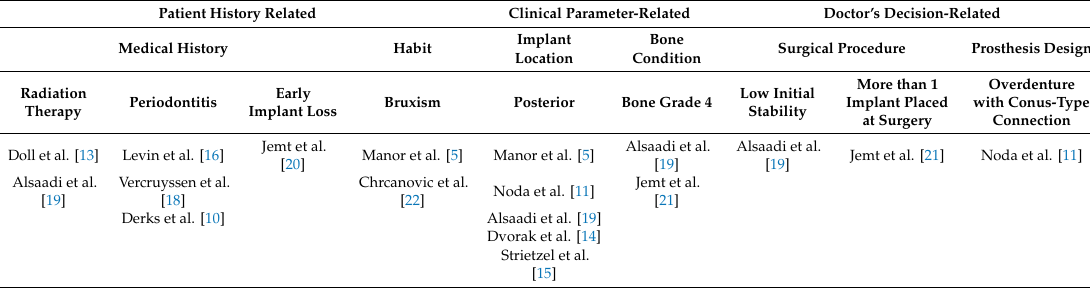
Table 3. Common risk factors associated with late dental implant